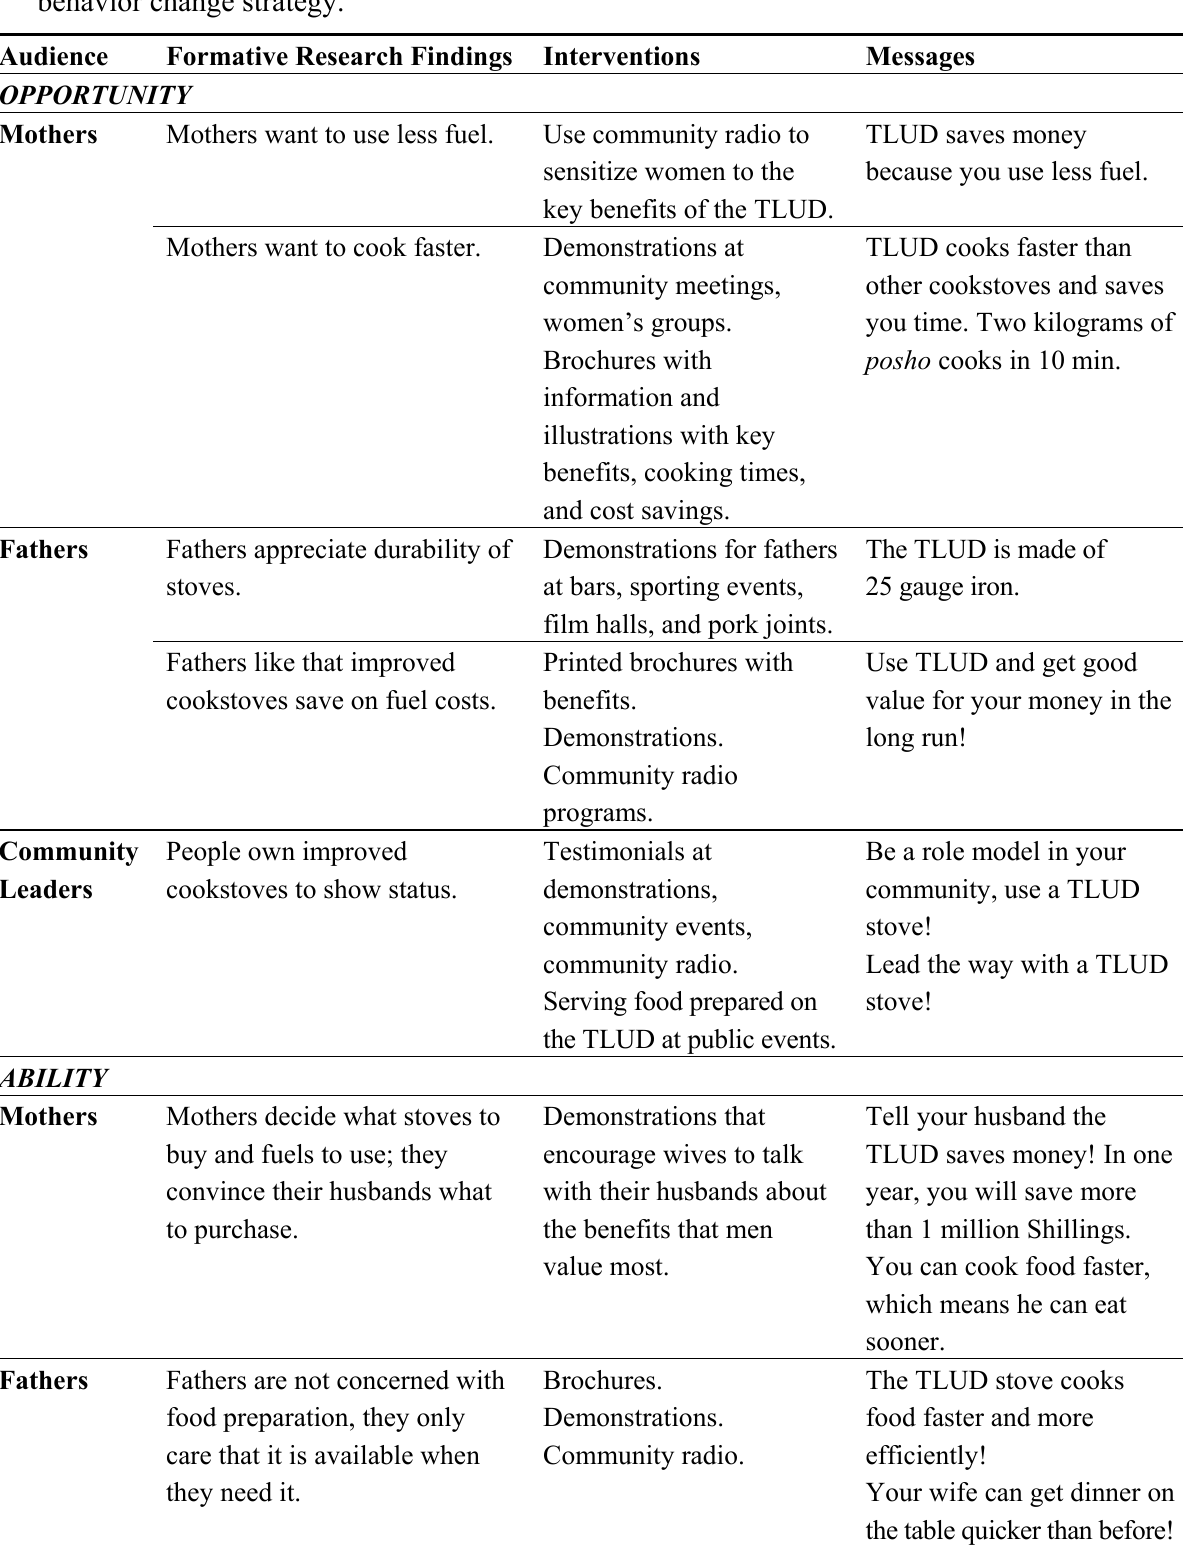
Table 2. Examples of formative research findings translated into an audience-specific behavior change